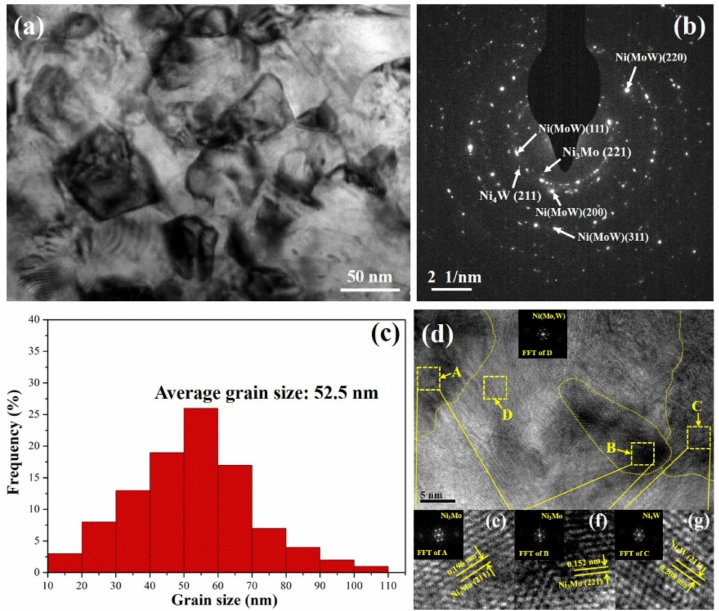
Figure 6. TEM images of the 600 ◦ C annealed Ni-Mo-W coating: ( a ) Bright-field image, and ( b ) cor- responding selected area diffraction (SAD) is displayed in inset of ( a ); ( c ) Grain size distribution represented in histogram; ( d ) HRTEM image, and FFT result of labeled D region is shown in inset of ( d ); ( e ), ( f ) and ( g ) are in response to IFFT of FFT results of the square regions marked A, B, and C, which are shown in inset of ( e ), ( f ) and ( g ),